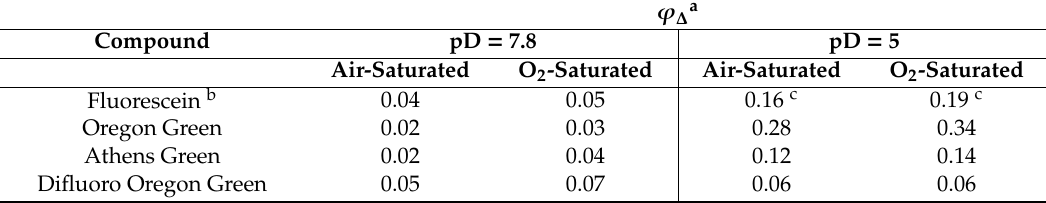
Table 3. Singlet oxygen quantum yields, ϕ ∆ , recorded from air- and oxygen-saturated D 2 O-PBS solutions. ϕ ∆ a Compound pD = 7.8 pD = 5 Air-Saturated O 2 -Saturated Air-Saturated O 2 -Saturated Fluorescein b 0.04 0.05 0.16 c 0.19 c Oregon Green 0.02 0.03 0.28 0.34 Athens Green 0.02 0.04 0.12 0.14